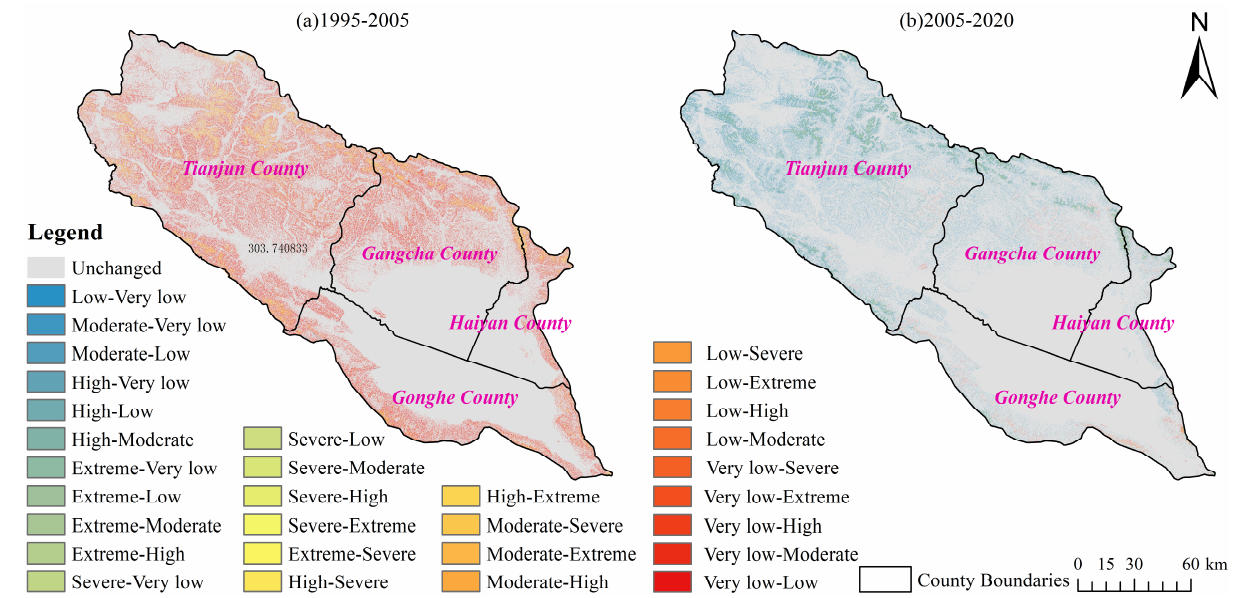
Figure 7. Spatial distribution map of SE grade transfer in the QLB. Table 5. Transfer matrix of SEI in QLB in 2005–2020